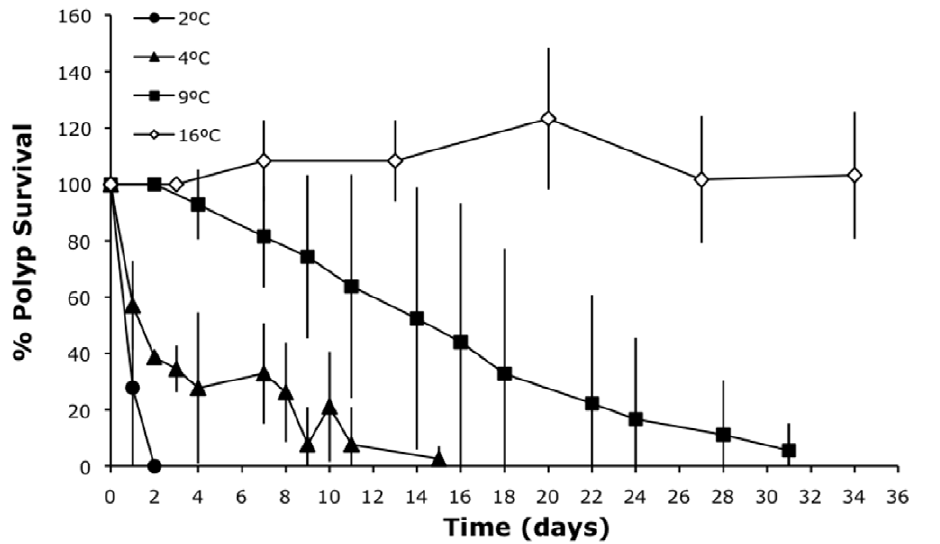
Figure 4. Polyp survival at low temperatures (Experiment E). Empty rhomboid, square, triangle and circle stand for 16, 9, 4 and 2 u C respectively. Error bars are the standard deviation of the three replicates’. Survival is greater than 100% at 16 u C because of budding.